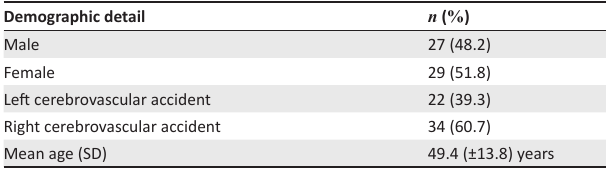
TABLE 3: Demographic information ( n = 56). TABLE 2: Ritchie articular index.